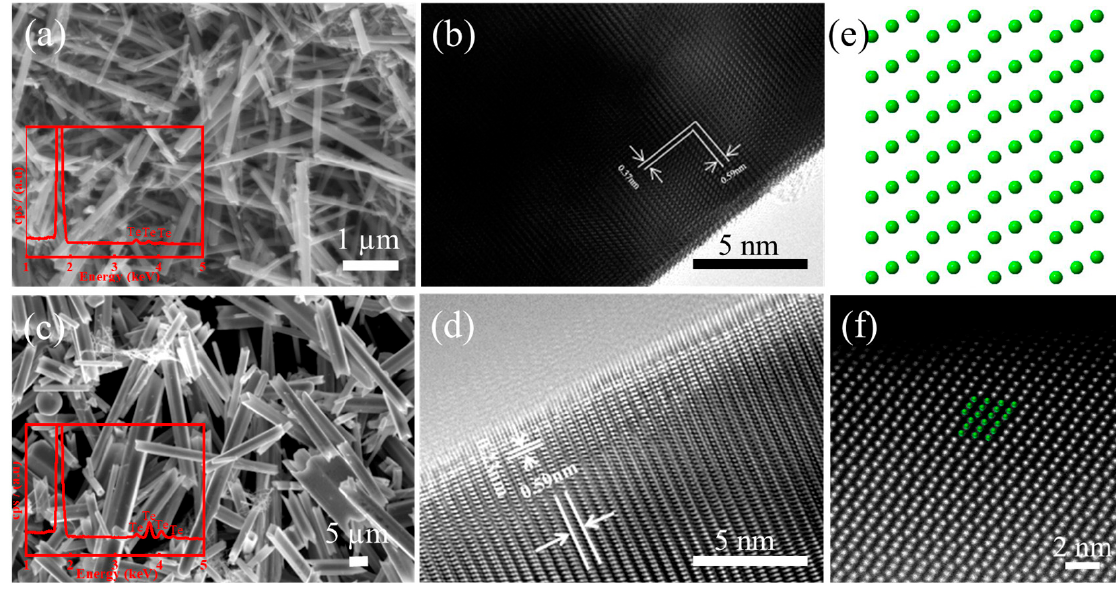
Figure 3. ( a ) SEM and ( b ) HRTEM images of the Te NTs obtained in 0.25 mL HH. ( c ) SEM and ( d ) HRTEM images of the Te NTs obtained in 2.55 mL HH. ( e ) Schematic crystal structure image of Te projected along [001] axis. ( f ) HAADF images of the Te NTs obtained in 2.55 mL HH projected along [001] axis.